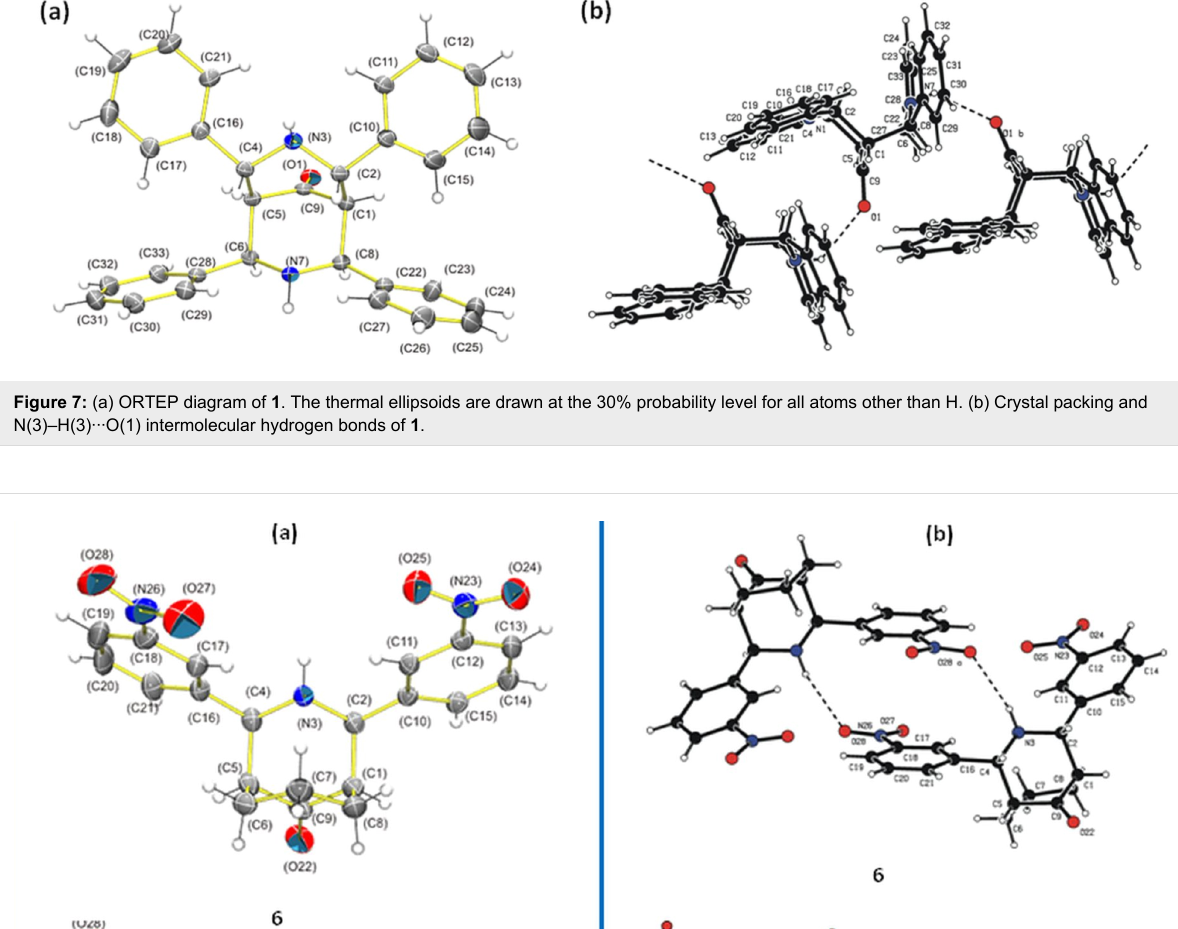
Hyperconjugation and homohyperconjugation in piperidones were investigated by analyzing the 1 J C,H coupling constants, which were measured in the 13 C satellites in the 1 H NMR spec- trum obtained with dqf-heteronuclear pulse sequence